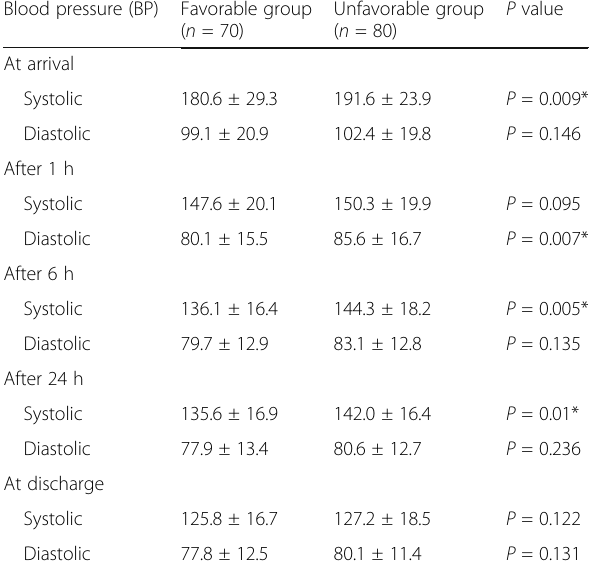
Table 3 Management of blood pressure in acute ICH Blood pressure (BP) Favorable group ( n =